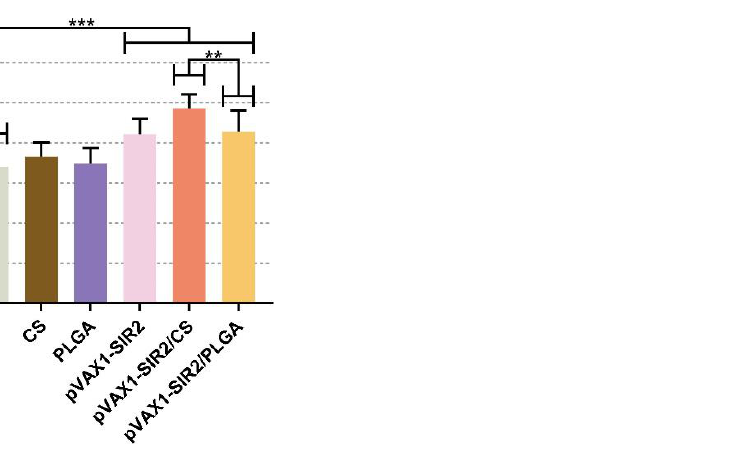
Figure 9. Splenocyte proliferation of immunized animals. Three mice from each group were euthanized, the spleen lymphocytes were collected, and the lymphocytes from one mouse were randomized into four replications. Then, the lymphocytes were cultured with 20 µ g/mL rTgSIR2 protein. Each replication was investigated once, and values were analyzed by one-way ANOVA analysis followed by Dunnett ’ s test. Values between the pVAX1-SIR2/CS and pVAX1-SIR2/PLGA group were estimated by the independent t -test. Values were shown as mean ± SD (n = 3). ** p < 0.01 and *** p < 0.001 compared with blank or control group.